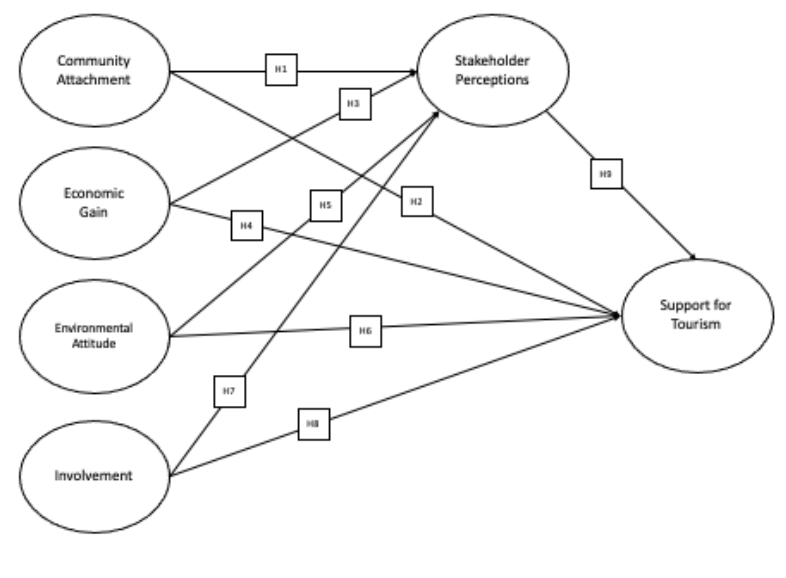
Figure 2: Conceptual framework Social Exchange Theory (SET) and Weber’s theory of substantive and formal rationality